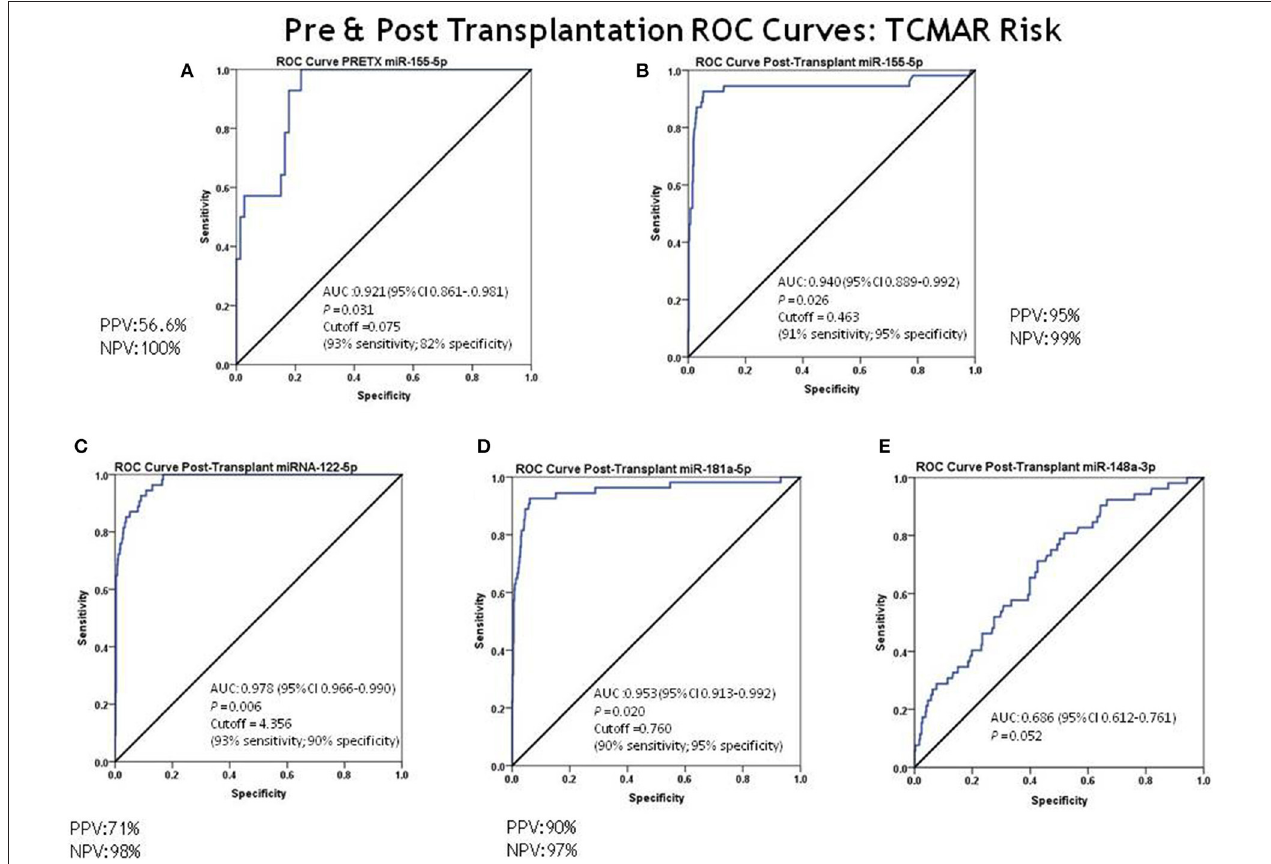
FIGURE 2 | ROC curve analysis for discrimination between rejectors (TCMAR) and non-rejectors. ROC curve analysis for discrimination between rejectors (TCMAR) and non-rejectors for each miRNA was evaluated. (A) Pre-transplantation miR-155-5p capacity to discriminate between rejectors and non-rejectors (AUC =